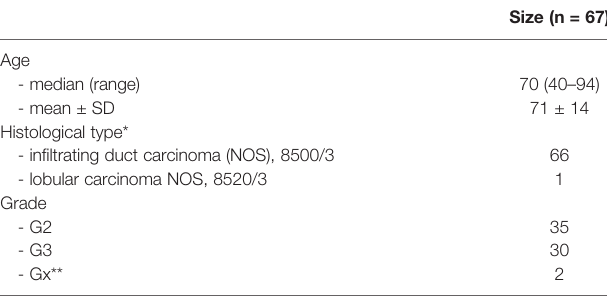
TABLE 1 | Detailed characteristics of the study